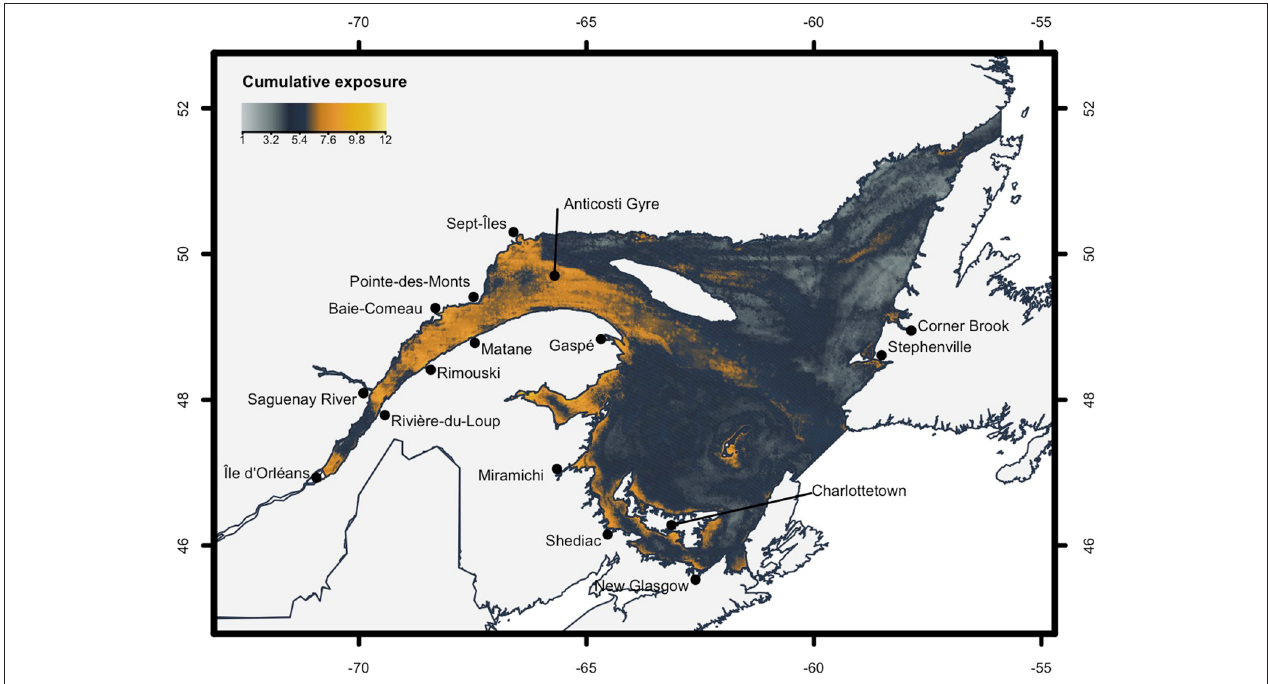
FIGURE 3 | Distribution of cumulative exposure in the St. Lawrence System.